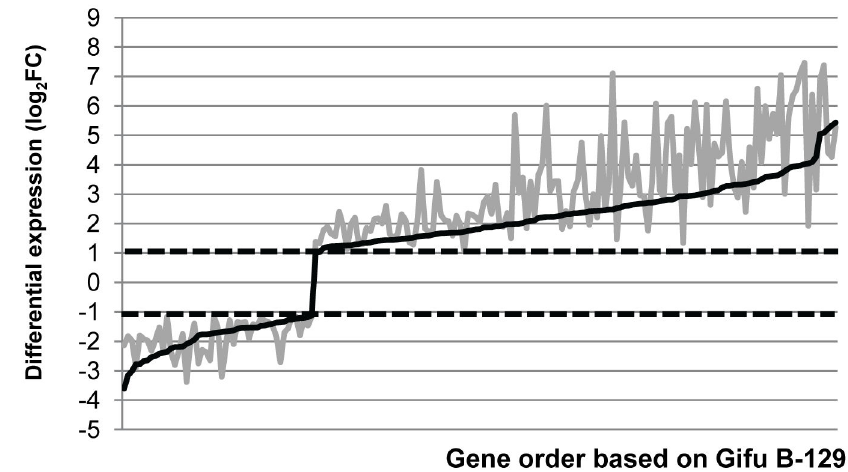
Figure 4. Trend plots comparing quantitative expression of differentially regulated genes in MG-20 and Gifu B-129. Gene order along the x axis was determined by the expression level in Gifu B-129 samples (dark lines). The expression of the same genes in MG-20 (grey lines) was plotted keeping the same